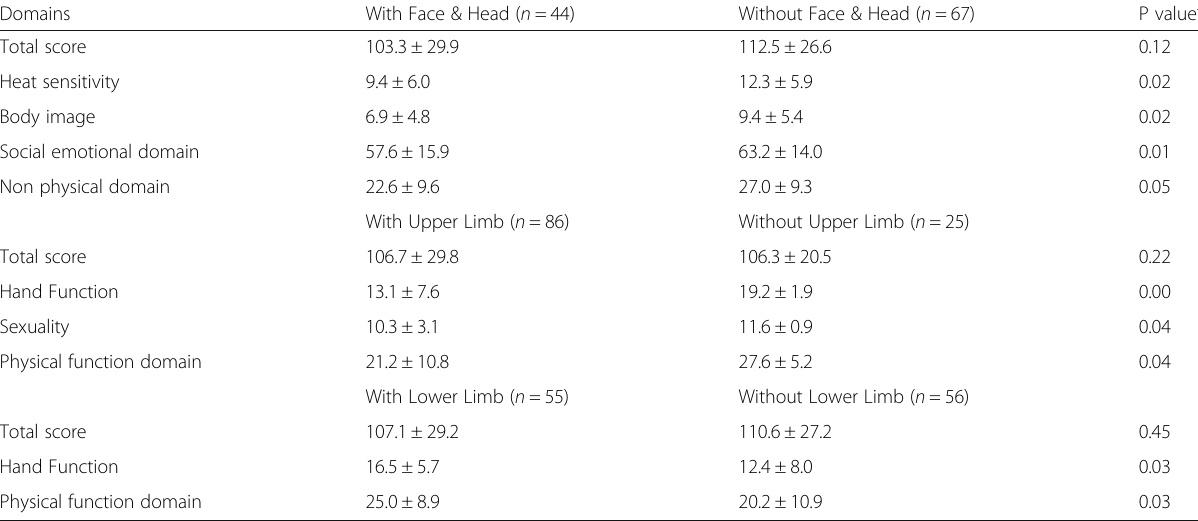
Table 6 Subgroup comparison of BSHS-B- Np Domains With Face & Head ( n =